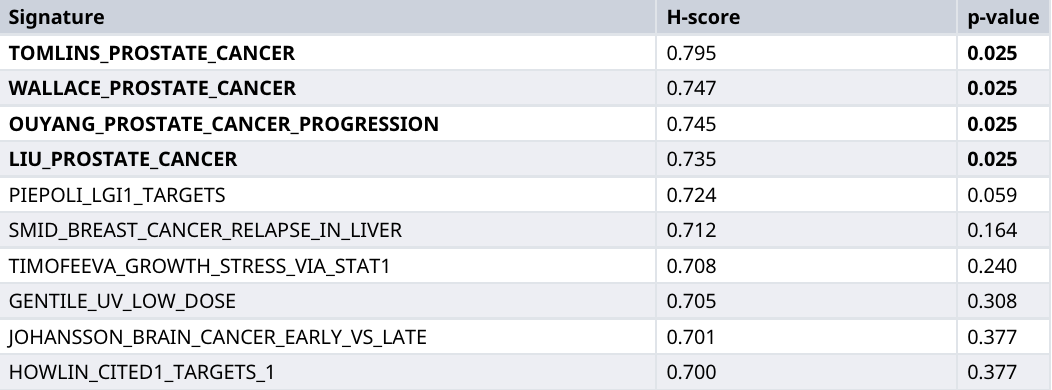
Table 1. Ten C2-chemical and genetic perturbations (GCP) Gene Signatures with the highest